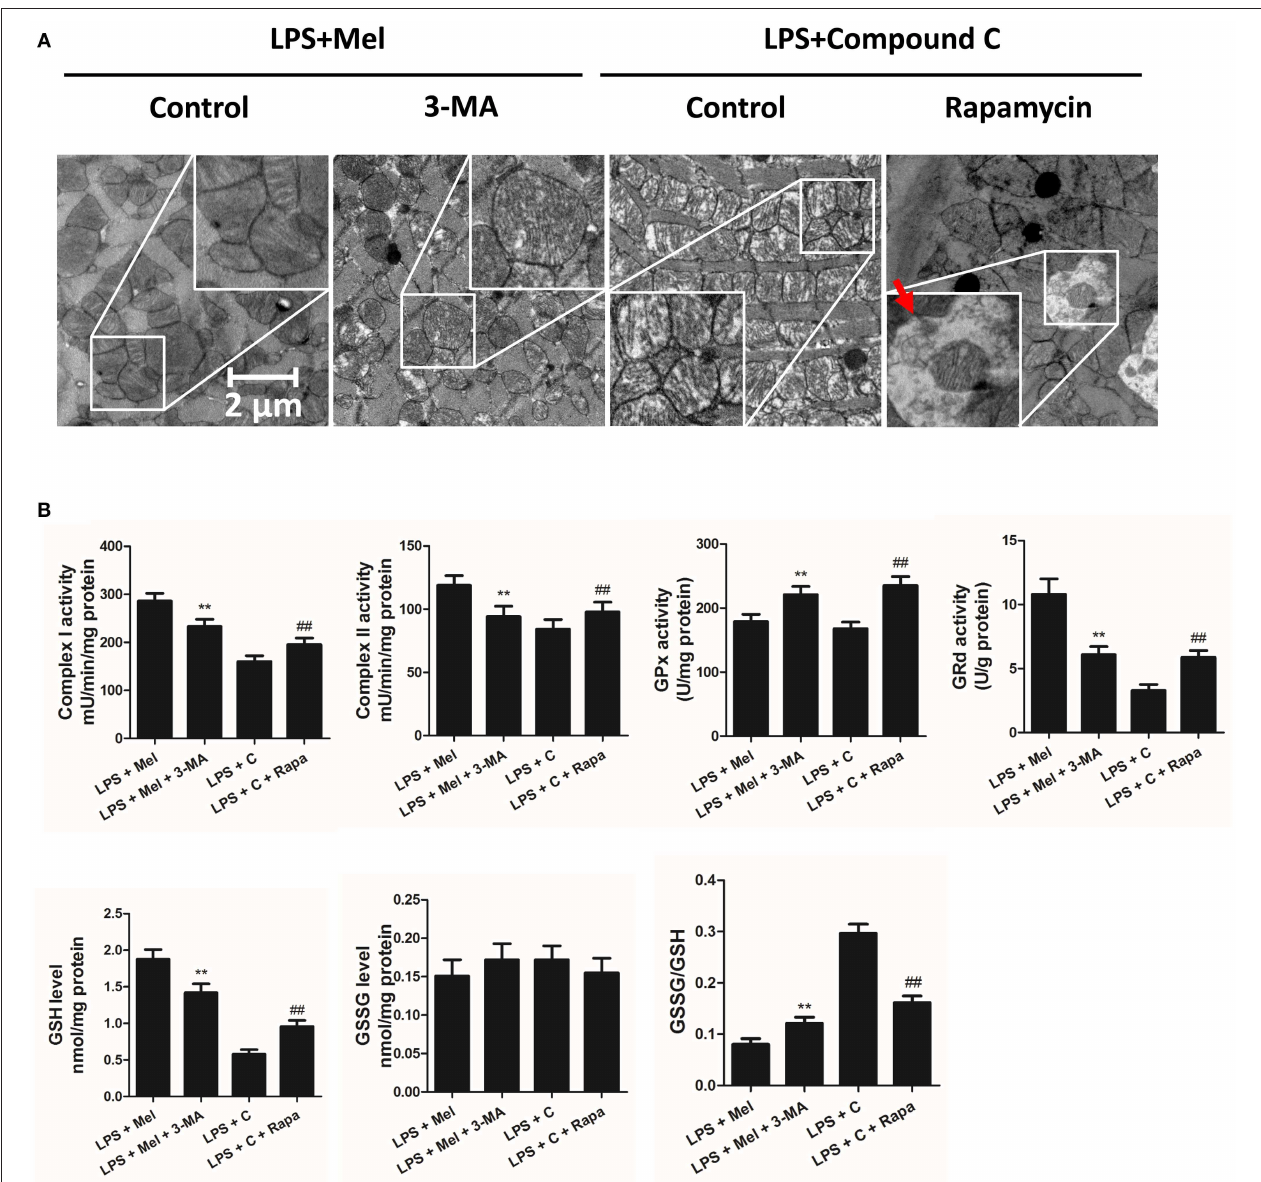
FIGURE 9 | Autophagy inhibition increased mitochondrial function, and autophagy activation decreased Compound C induced mitochondrial dysfunction. (A) Representative images of mitochondrial morphology. The red arrow indicates an autophagosome (B) Quantitative analysis of mitochondrial Complex I, Complex II, GPx and GPd activity, and GSH, GSSG levels. n = 6 ** P < 0.05 vs. the LPS + melatonin group, ## P < 0.05 vs. the LPS + Compound C group. Mel, melatonin; C, Compound C; Rapa,